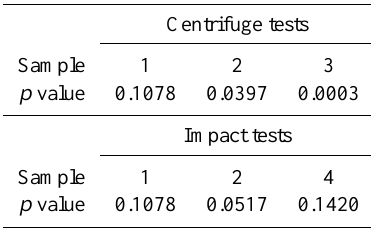
Table 6. p values from paired t test of the means for 14 ◦